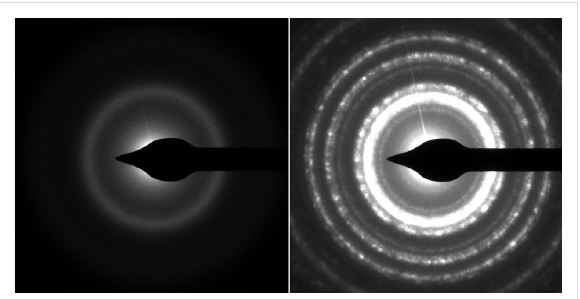
Figure 9: TEM electron diffraction pattern of samples on carbon membrane before (left) and after (right) postgrowth electron irradiation. The phase transformation from an amorphous to a crystalline state of the Co–Pt grains is apparent. See text for details. Images reproduced from Porrati et al.